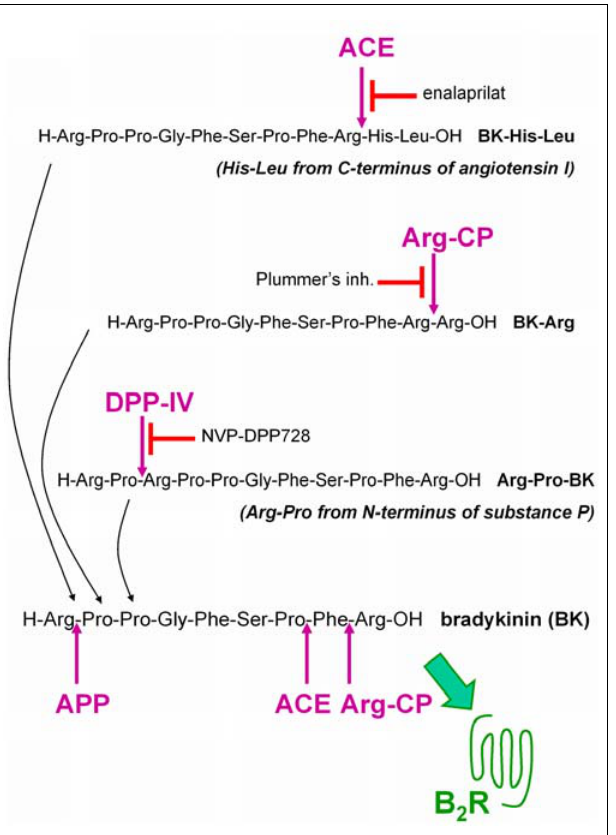
FIGURE 1 | Extended BK sequences as potential “prodrug” agonists of the B 2 R activated by peptidases. BK is itself degraded by several peptidases that terminate its signaling at B 2 Rs. ACE: angiotensin converting enzyme; APP: aminopeptidase P; Arg-CP: arginine carboxypeptidases; DPP IV: dipeptidyl peptidase-4.